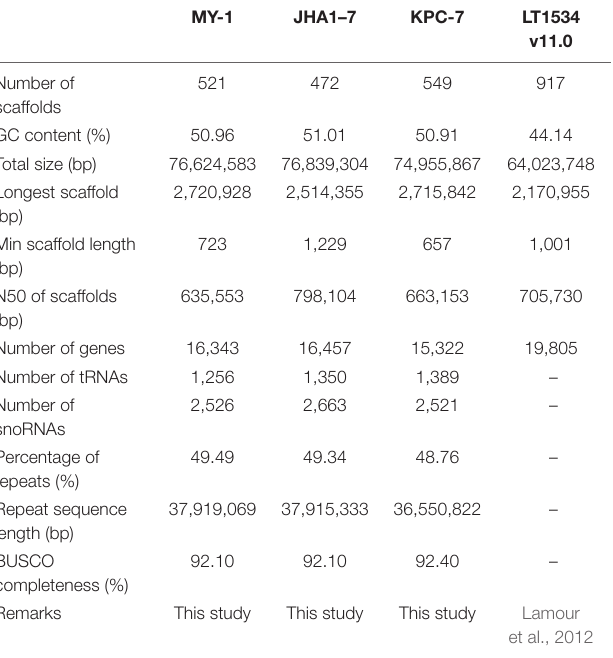
TABLE 1 | Statistics of the P. capsici genome assembly